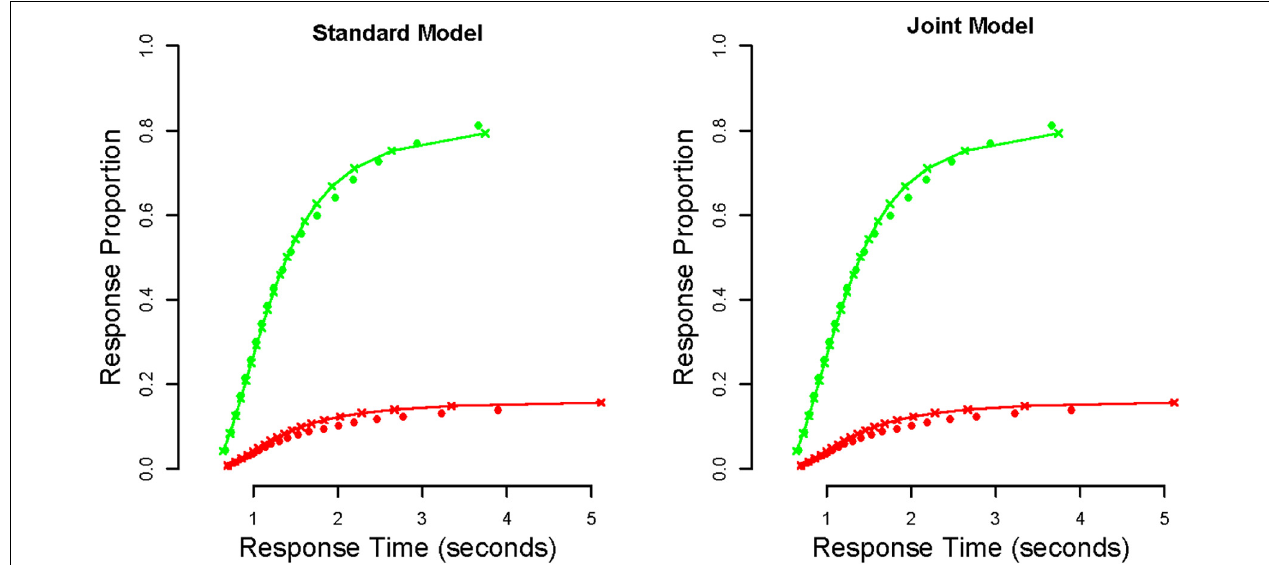
FIGURE 2 | Defective cumulative density function plots that display the goodness-of-fit of the LBA to the perceptual decision-making data. The x -axis displays the response times and the y -axis displays the response proportions, with different points showing different response time quantiles. Red points display error responses, whereas green points display correct responses. Dots display the empirical data, and lines (with crosses) display the posterior model predictions. The left panel displays the group-averaged fits for the standard model (i.e., used to estimate the median threshold), and the right panel displays the group-averaged fits for the joint model. In both cases, the model appears to provide a generally good account of the